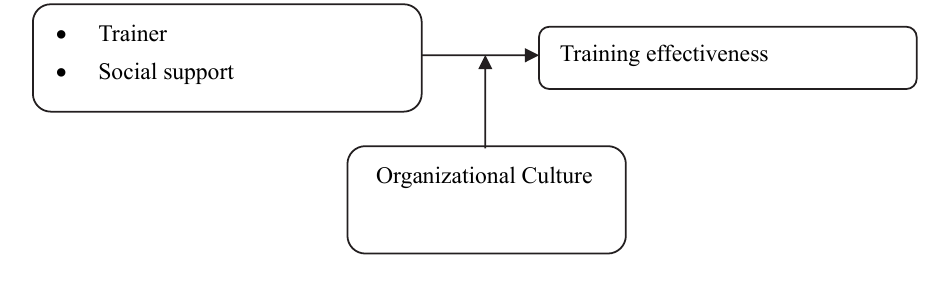
Fig. 1. Research Framework of the